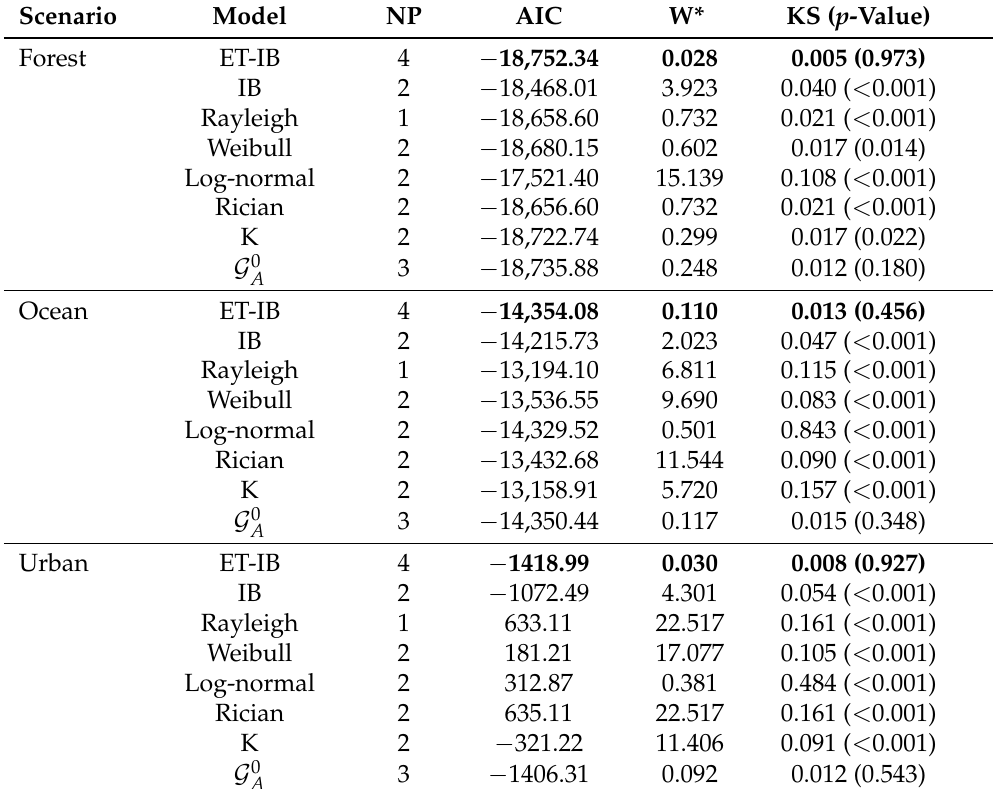
Table 3. GoF measures for different probability distributions considering the forest, ocean, and urban region datasets. The best results are presented in bold font.